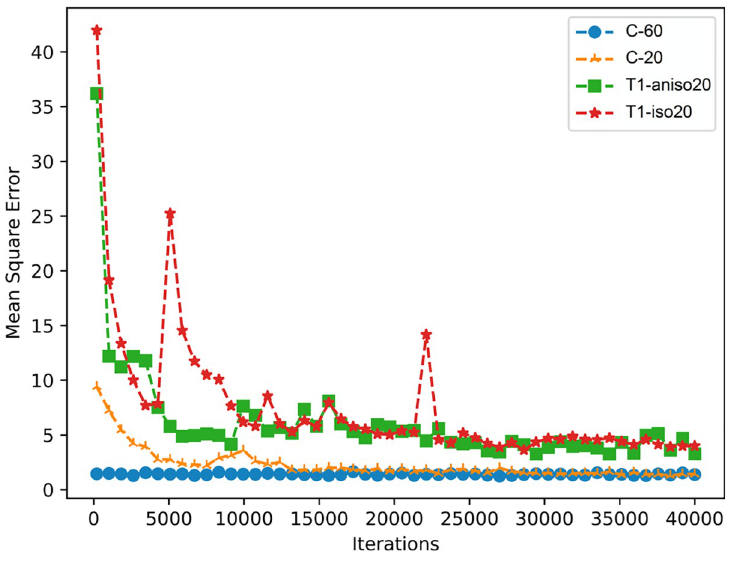
Fig 2. The training loss for the four DNNs in each iteration.